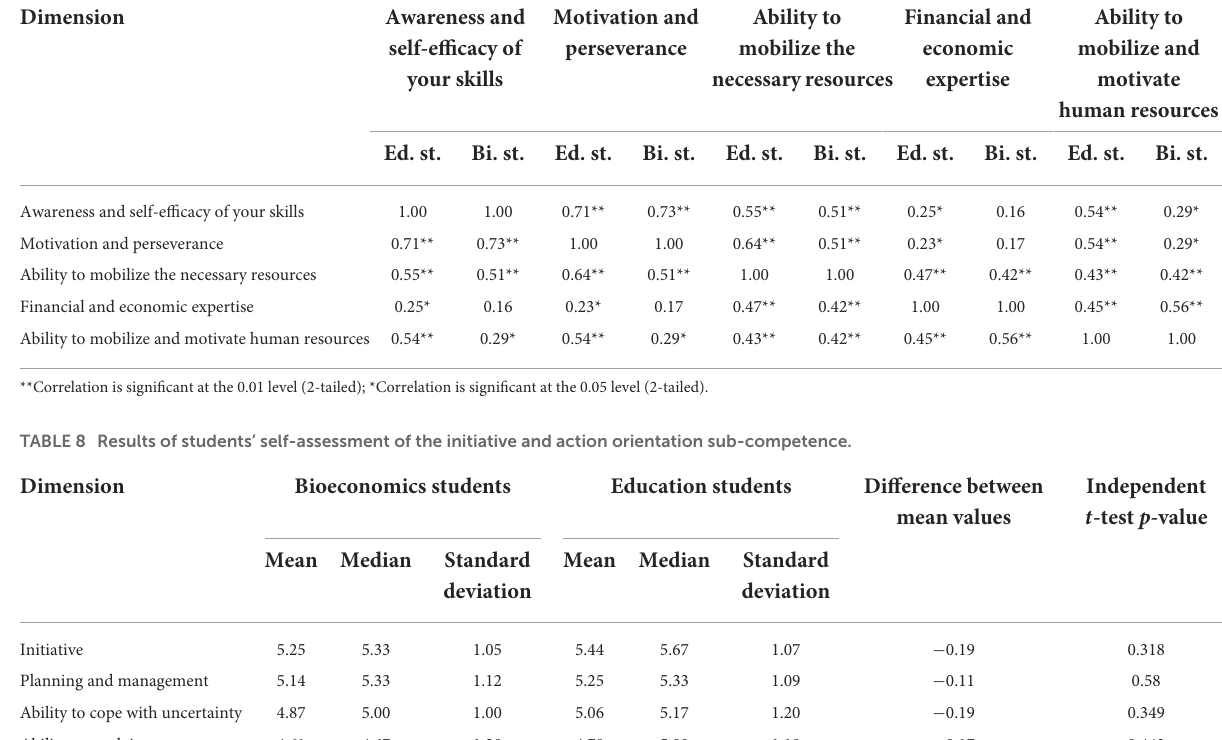
Motivation and Ability to Financial and Ability to self-efficacy of perseverance mobilize the economic mobilize and your skills necessaryresources expertise motivate